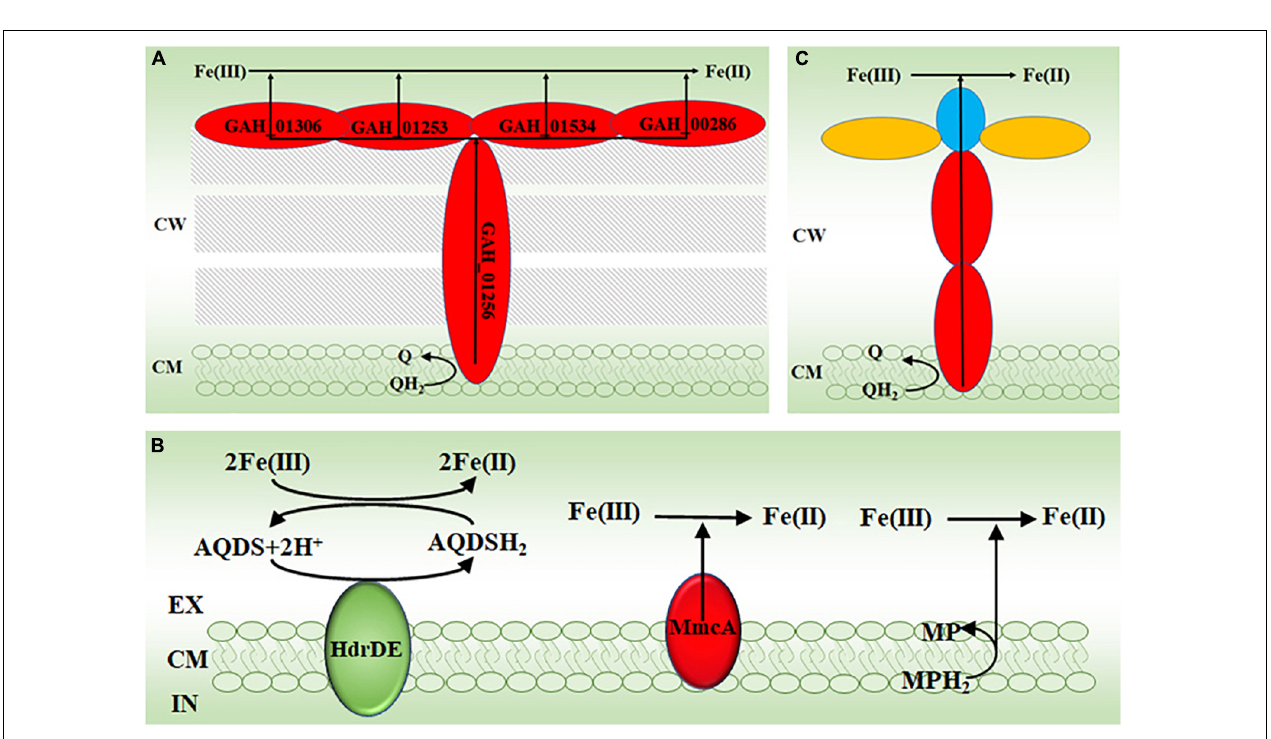
FIGURE 2 | The proposed molecular mechanisms for reducing Fe(III) by archaea. (A) The proposed electron transfer pathway for extracellular reduction of Fe(III) by the thermophilic archaeon Geoglobus ahangari . (B) The proposed electron transfer mechanisms for extracellular reduction of Fe(III) by the methanogen Methanosarcina acetivorans (Yan et al., 2018). (C) The proposed electron transfer pathway for extracellular reduction of Fe(III) by the anaerobic methane-oxidizing archaea. EX, extracellular; CM, cytoplasmic membrane; CW, cell wall; IN, intracellular; AQDS, oxidized anthraquinone-2,6-disulphonate; AQDSH 2 , reduced AQDS; HdrDE, heterodisulfide reductase; MmcA, the cytoplasmic membrane multiheme c -type cytochrome A; MP, oxidized methanophenazine; MPH 2 , reduced MP; Q, quinone; QH 2 , quinol. The c -type cytochromes are labeled in red; the c -type cytochromes with S-layer protein domains are labeled in blue; the S-layer proteins are labeled in